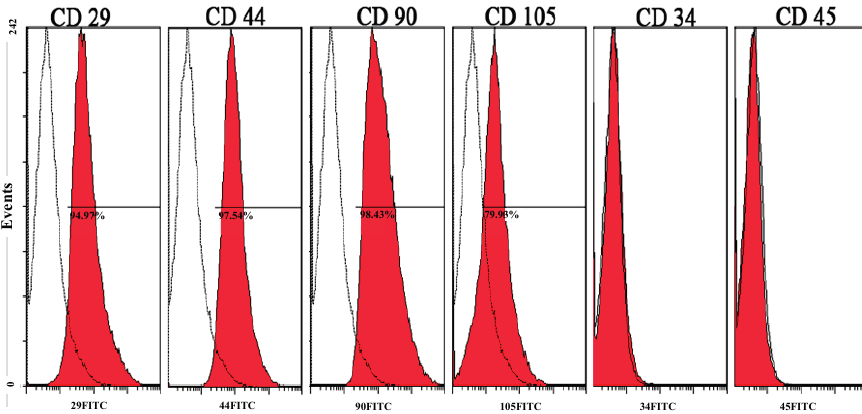
Figure 2. The identification of SF-MSCs by flow cytometry. When the area with red color was overlapped with the area without red color, it means the cluster of differentiation (CD) marker is not expressed. Three SF-MSCs samples were performed for this